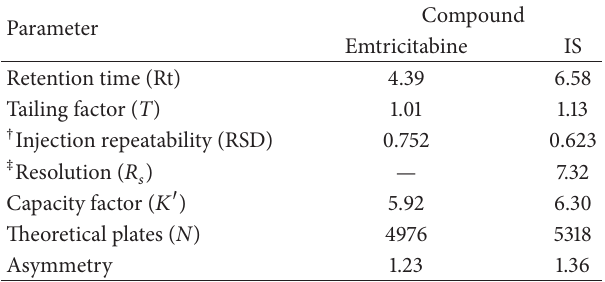
Table 3: System suitability parameters. Table 4: Intraday and interday precision and accuracy of emtric- itabine in rat plasma ( n =